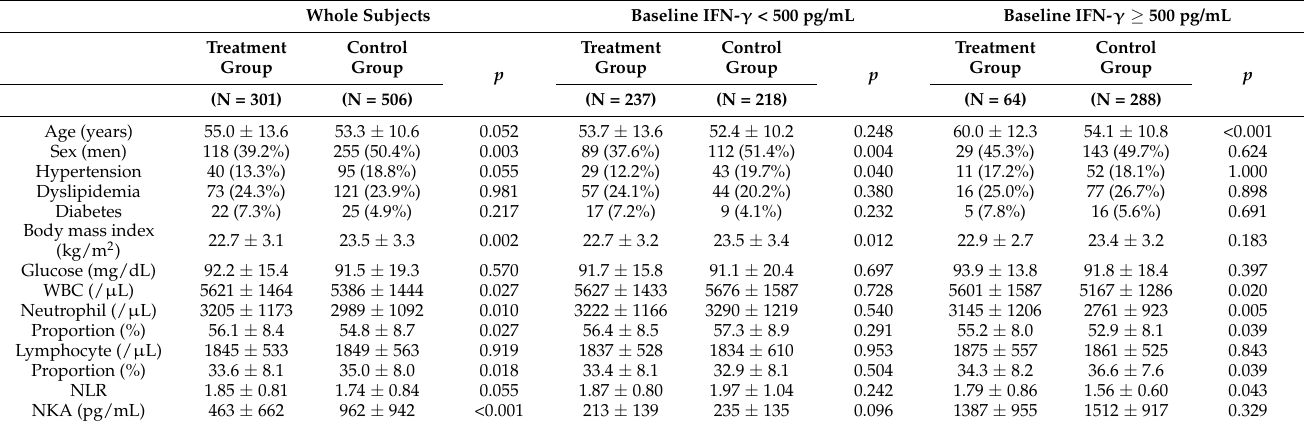
Table 1. The baseline characteristics of the patient and control